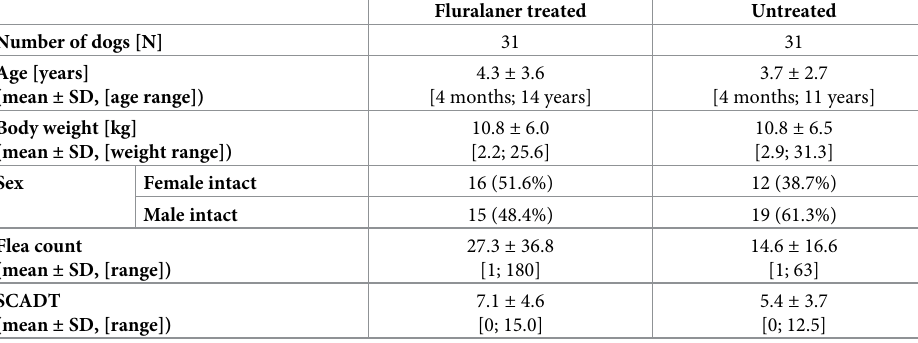
Table 2. Distribution of age, weight, sex, flea count and total severity score (SCADT) on Day